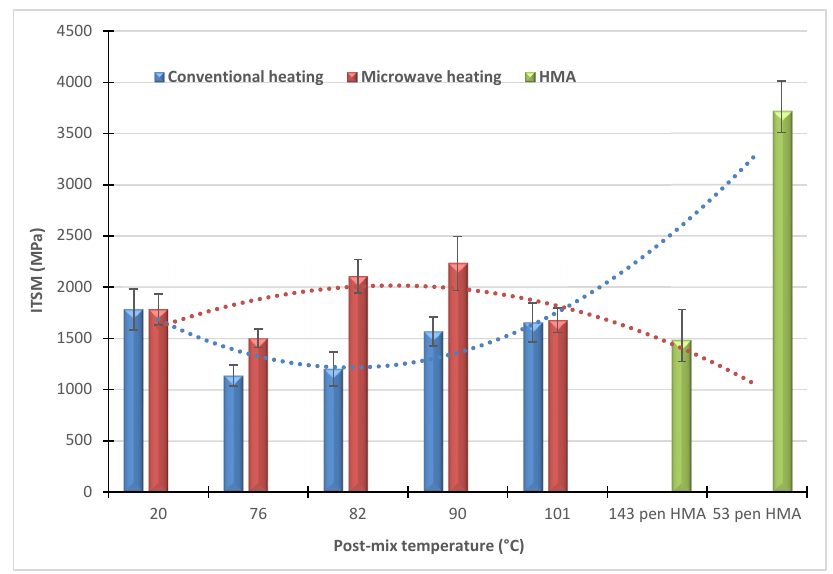
Figure 2. Impact of post-mix time on ITSM of CBEMs containing 5.5% PSA after 2 curing days .